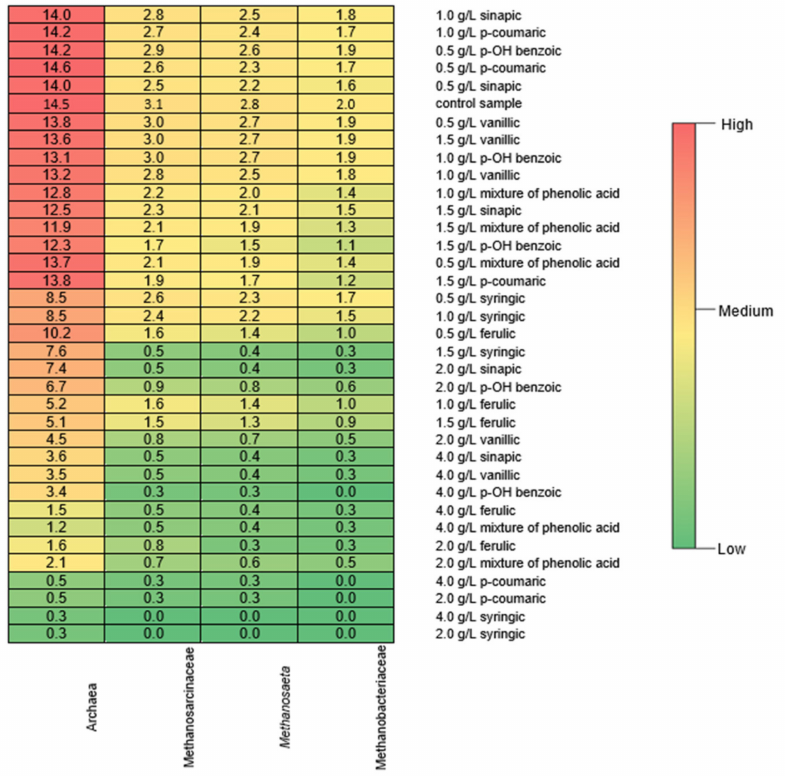
Figure 5. Heatmap of the abundance of Archaea and methanogens (%) in digestate. Grouping was based on hierarchical agglomerative clustering. The abundance of Archaea is represented by a color (light blue means lower abundance; dark blue means higher abundance). The color key is indicated in the legend in the top left of the plot along with the count of the abundance of Archaea in each titer. In fermented distillery stillage, the acetoclastic methanogens (Methanosarcinaceae and Methanosaeta ) and hydrogenotrophic methanogens (Methanobacteriaceae) most com- monly present in fermented biomass were detected. Methanosarcinaceae can use hydrogen and carbon dioxide, methylated compounds, and acetate for methane generation